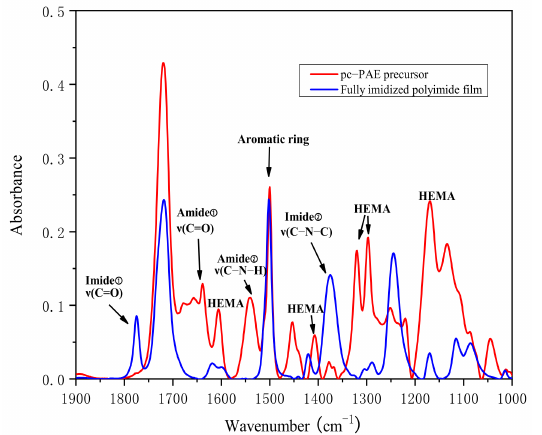
Figure 2. FT-IR spectra of the pc-PAE resin (red) and the fully imidized polymer films (blue).